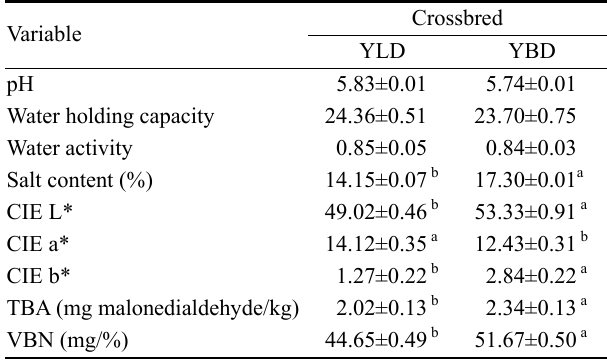
Table 2. Quality traits of dry-cured ham made from two different three-way crossbreed pigs